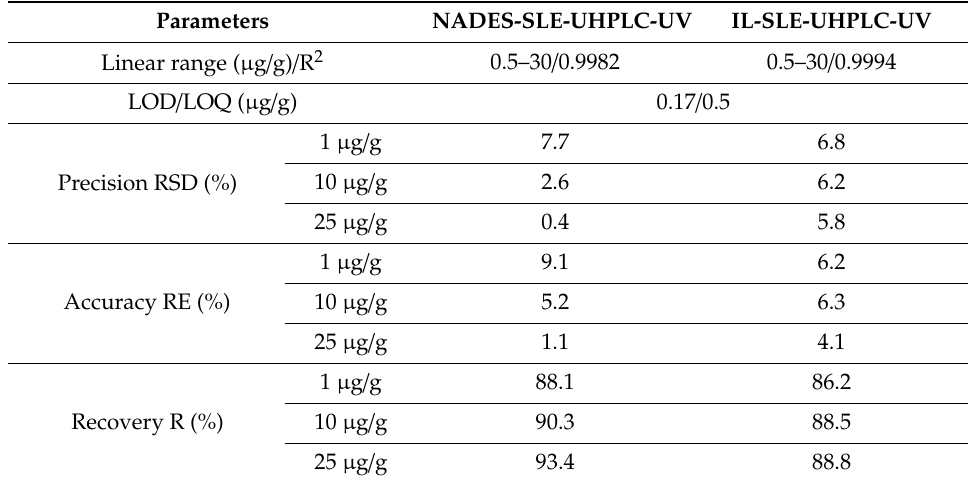
Table 1. Analytical characteristics of NADES-SLE-UHPLC-UV and IL-SLE-UHPLC-UV methods.